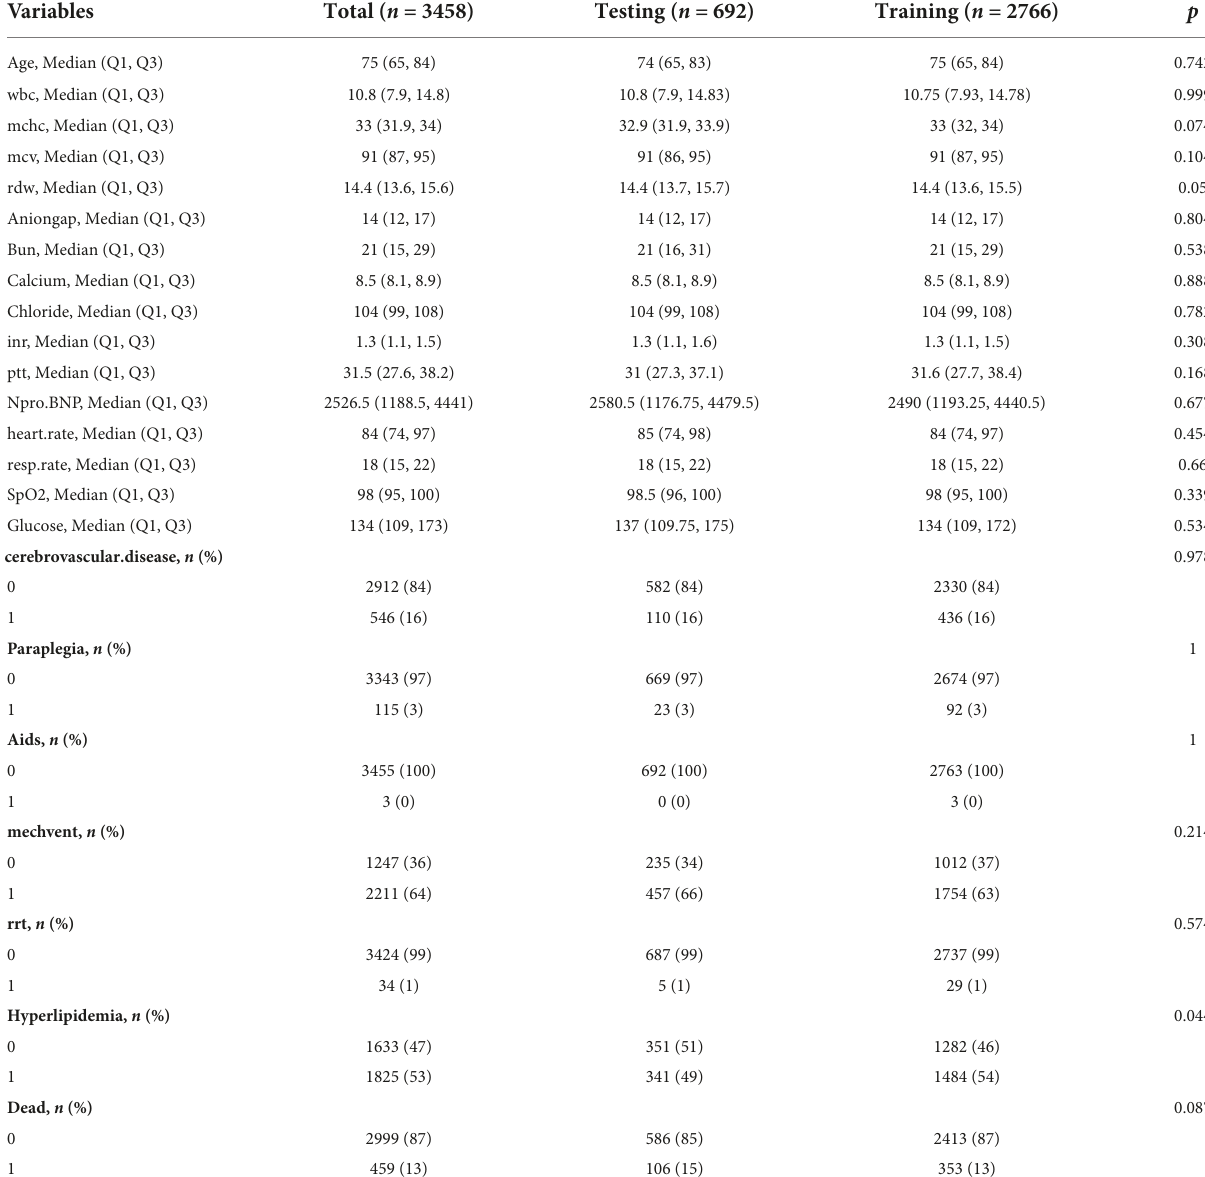
TABLE 2 Comparison of clinical characteristics between the training and testing